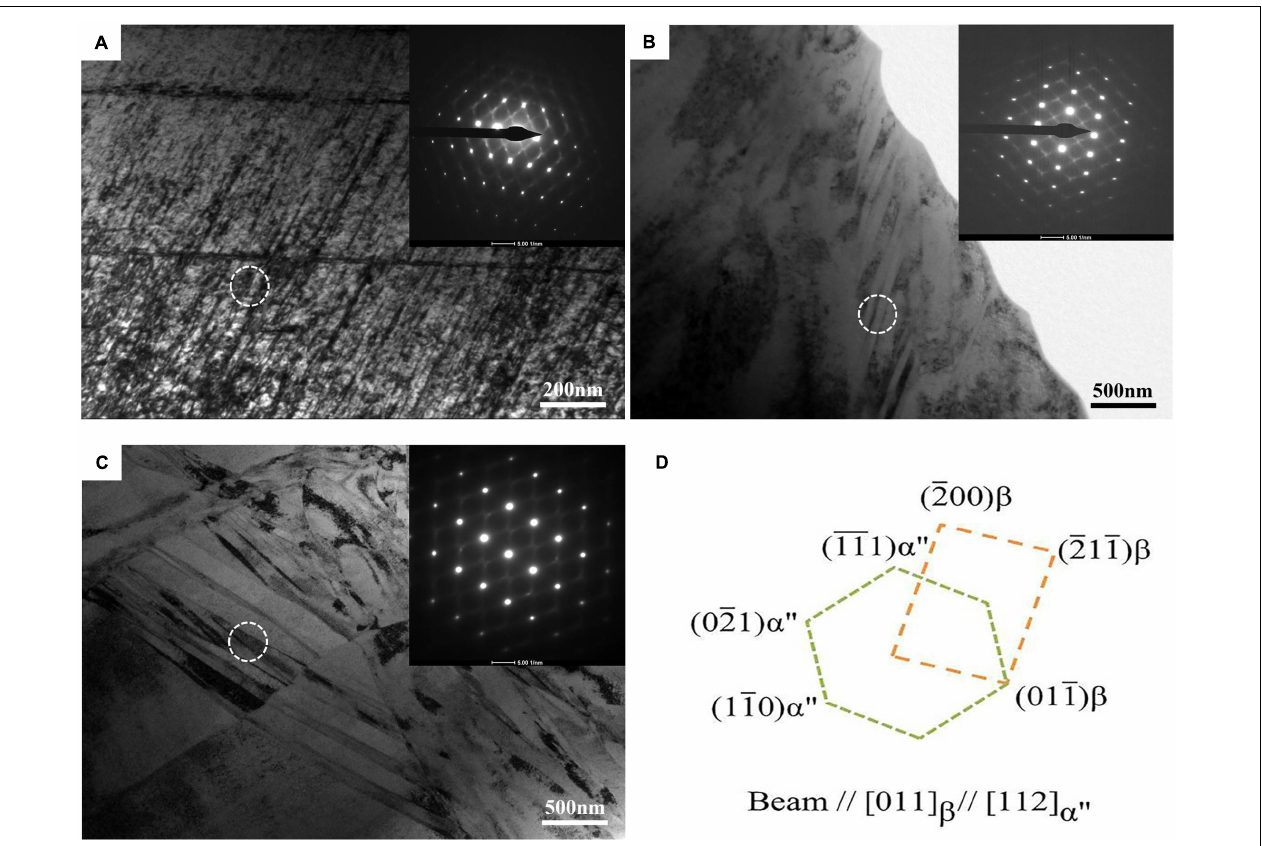
FIGURE 3 | TEM BF images and SAD patterns of the Ti–10Mo–6Zr–4Sn–3Nb alloy cold swaged with reductions of: (A) 25%, (B) 55%, and (C) 75%, (D) Schematic diagram of the Burgers relationship between stress-induced martensite and the β matrix (BF: Bright Field; SAD: Selected Area Diffraction).